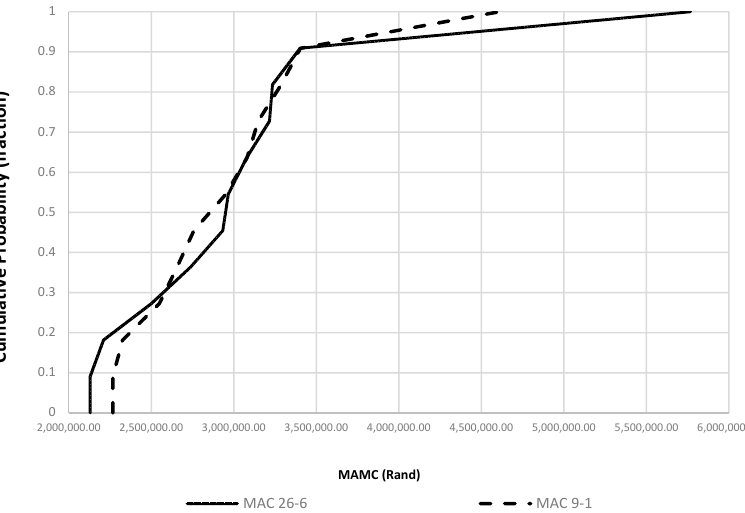
Figure 5. Cumulative probability distribution for optimal moving average crossover (MAC) mar- keting strategies for risk-averse and risk-neutral decisions makers over the 11 marketing years. Source: Author’s compilation.